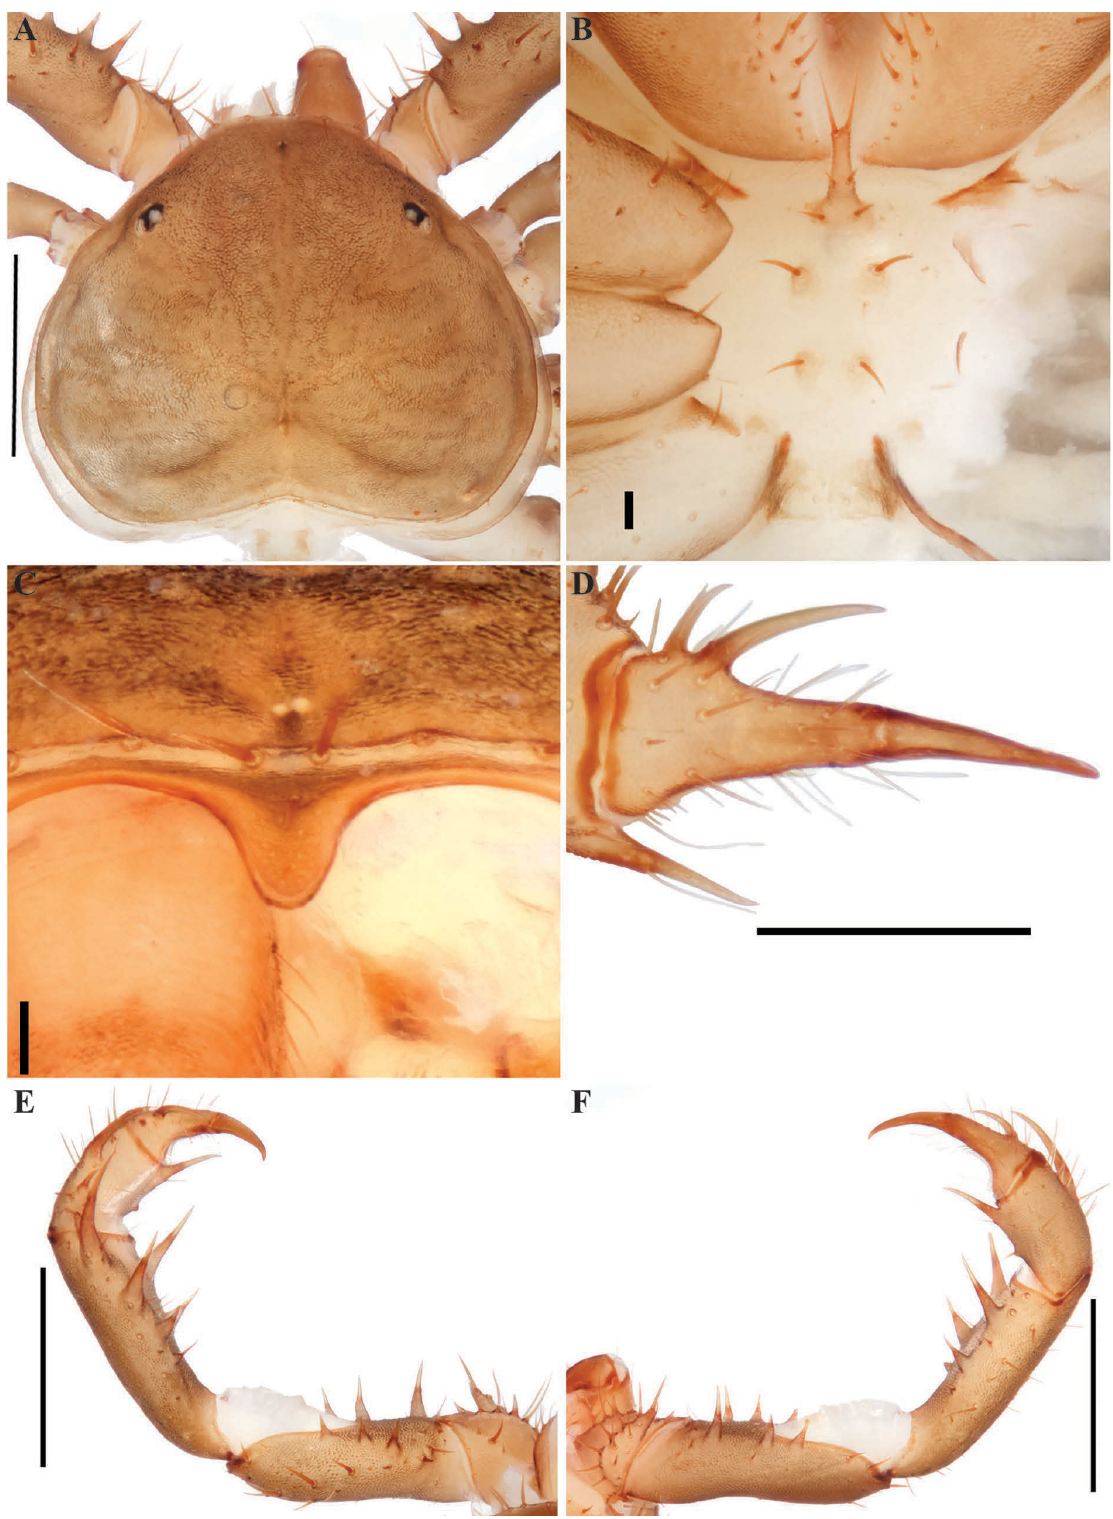
Fig. 20. Charinus cubensis (Quintero, 1983) (USNM 784407), general morphology, ♀. A . Carapace, dorsal view. B . Sternum, ventral view. C . Frontal process. D . Pedipalp tarsus, frontal view. E . Pedipalp, dorsal view. F . Pedipalp, ventral view. Scale bars: A, E–F = 1 mm; B = 0.1 mm; C–D = 0.5 mm.